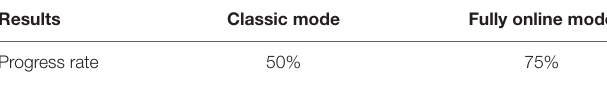
TABLE 4 | Experimental results of two